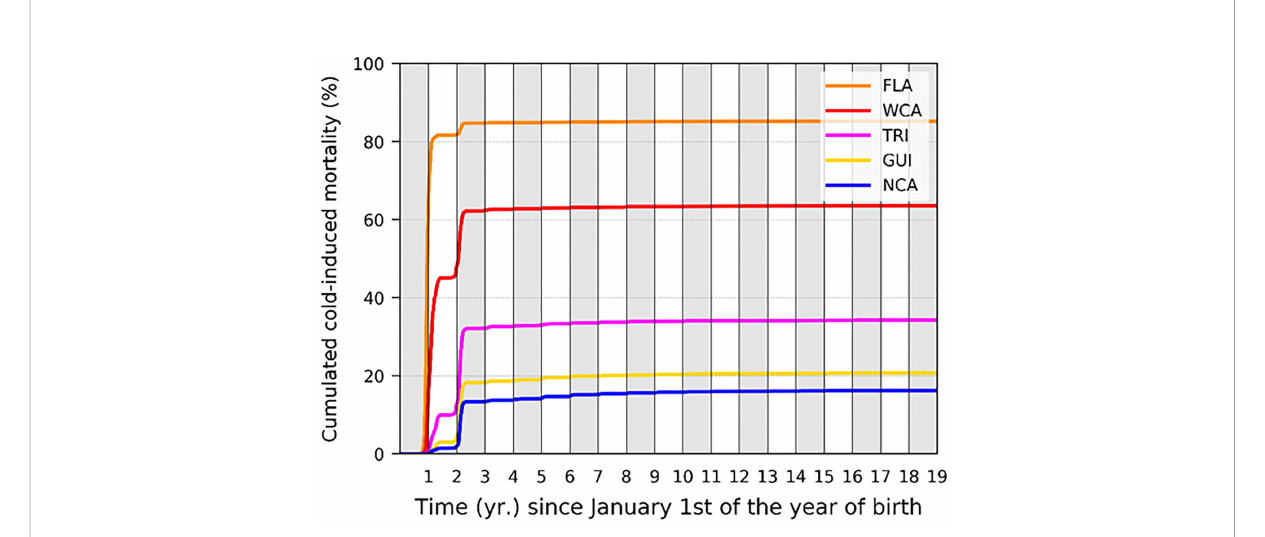
FIGURE 5 Cumulated cold-induced mortality in each of the fi ve